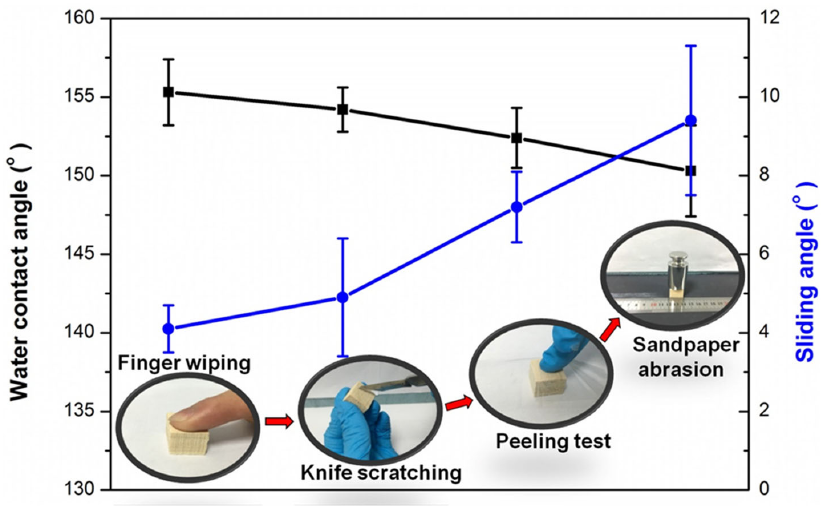
Figure 5. Changes in the WCA and SA during a sequential abrasions, including finger wiping, knife scratching, tape peeling, and sandpaper abrasion.